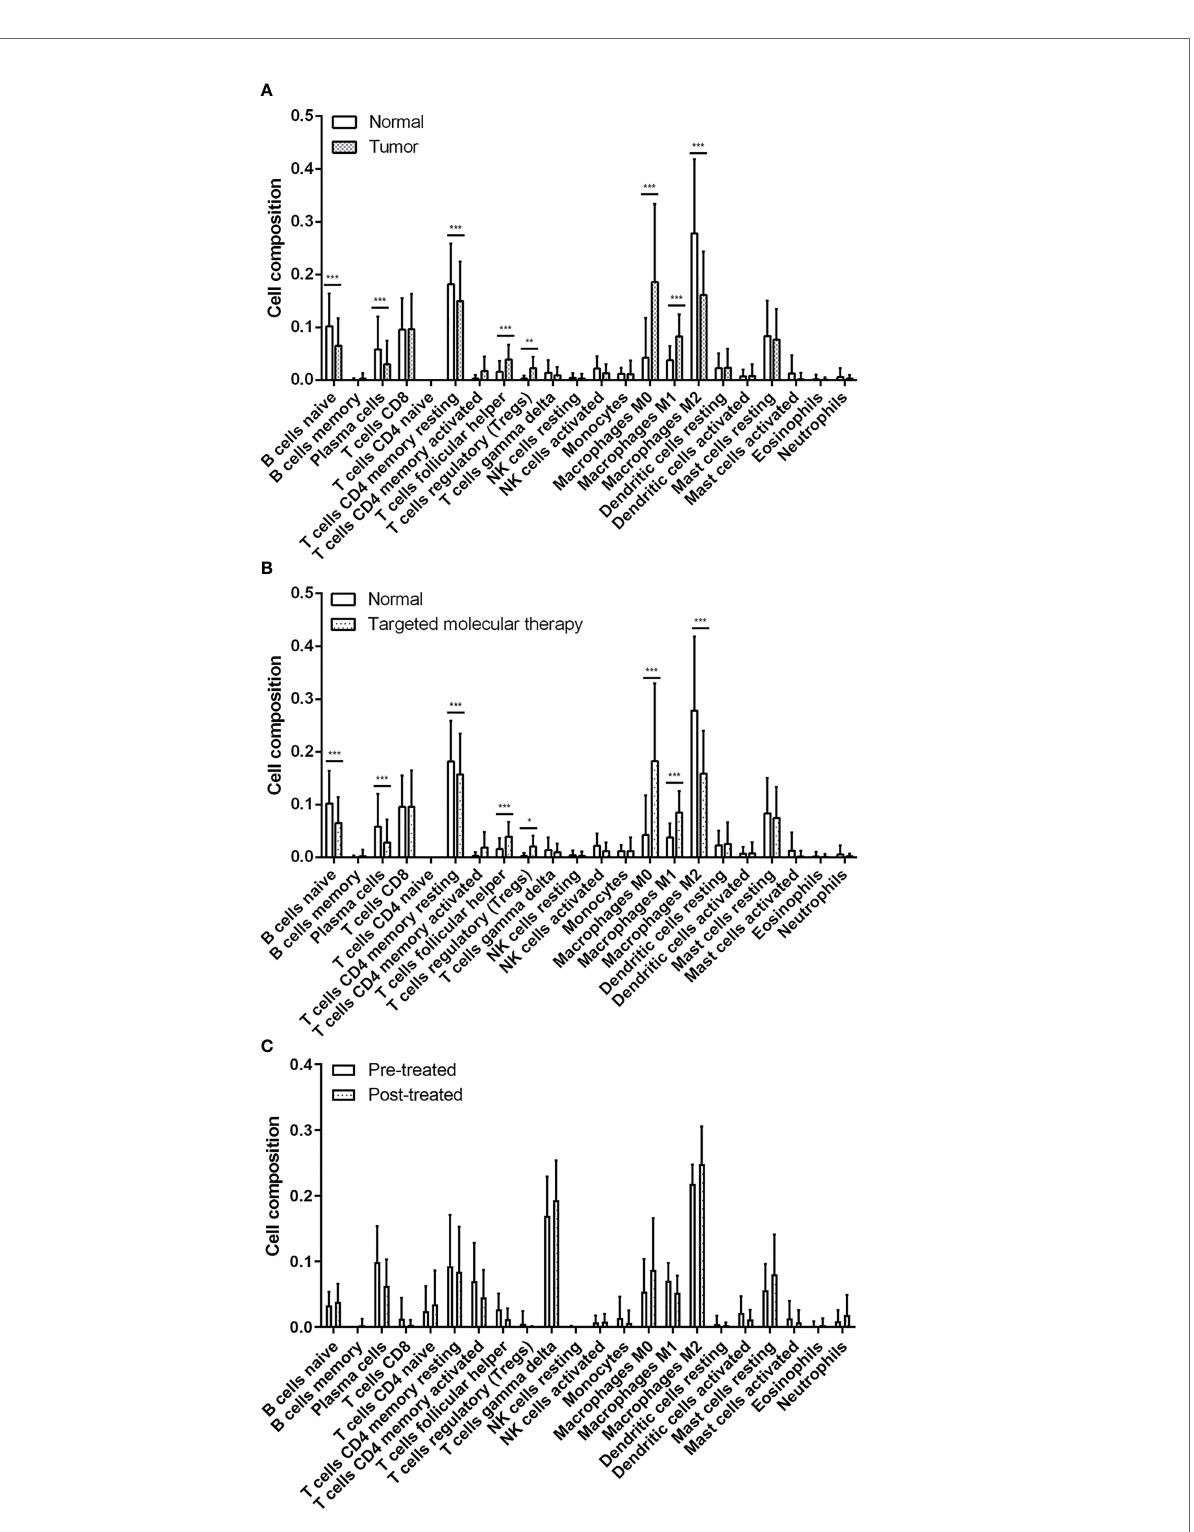
FIGURE 2 | The evaluation of tumor-related in fi ltrating lymphocytes using the CIBERSORT algorithm. (A) Signi fi cant statistical analysis of tumor-related in fi ltration lymphocytes between normal samples and breast tumor samples. (B) Signi fi cant statistical analysis of tumor-related in fi ltration lymphocytes between normal tissues and breast tumor samples with targeted molecular therapy. (C) Signi fi cant statistical analysis of tumor-related in fi ltration lymphocytes between breast tumor samples before and after treated by trastuzumab. The data were presented as the mean ± SD, normal vs. tumor, pretreatment vs. posttreatment. * p < 0.05; ** p < 0.01; *** p <